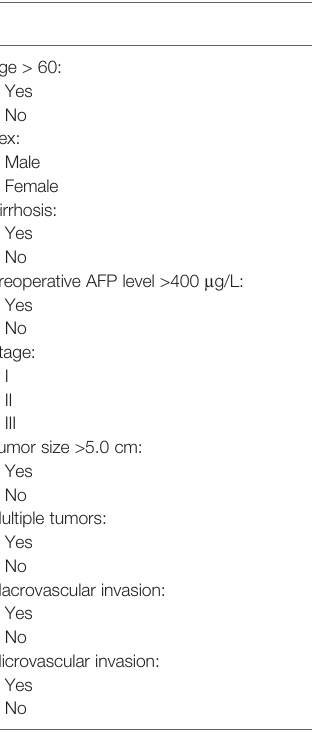
TABLE 1 | Detail clinical data of qRT-PCR data from 103